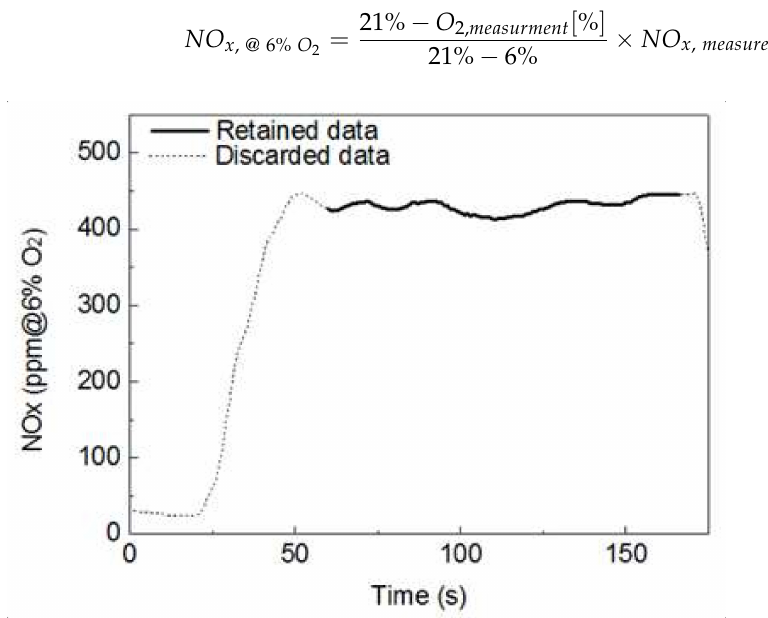
Figure 3. Plot showing an example of the processing of data used for analysis of the exhaust